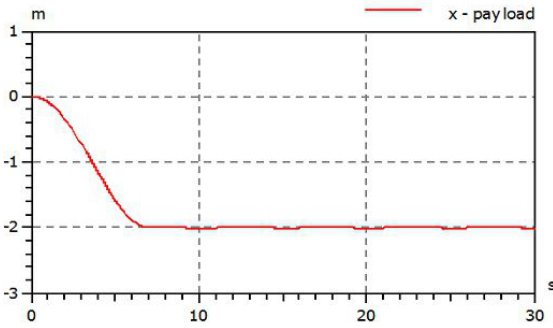
Figure 20. Set point was set to 4 m. Rise time of ca. 5.5 s with no overshoot. Oscillation of ± 1 cm.